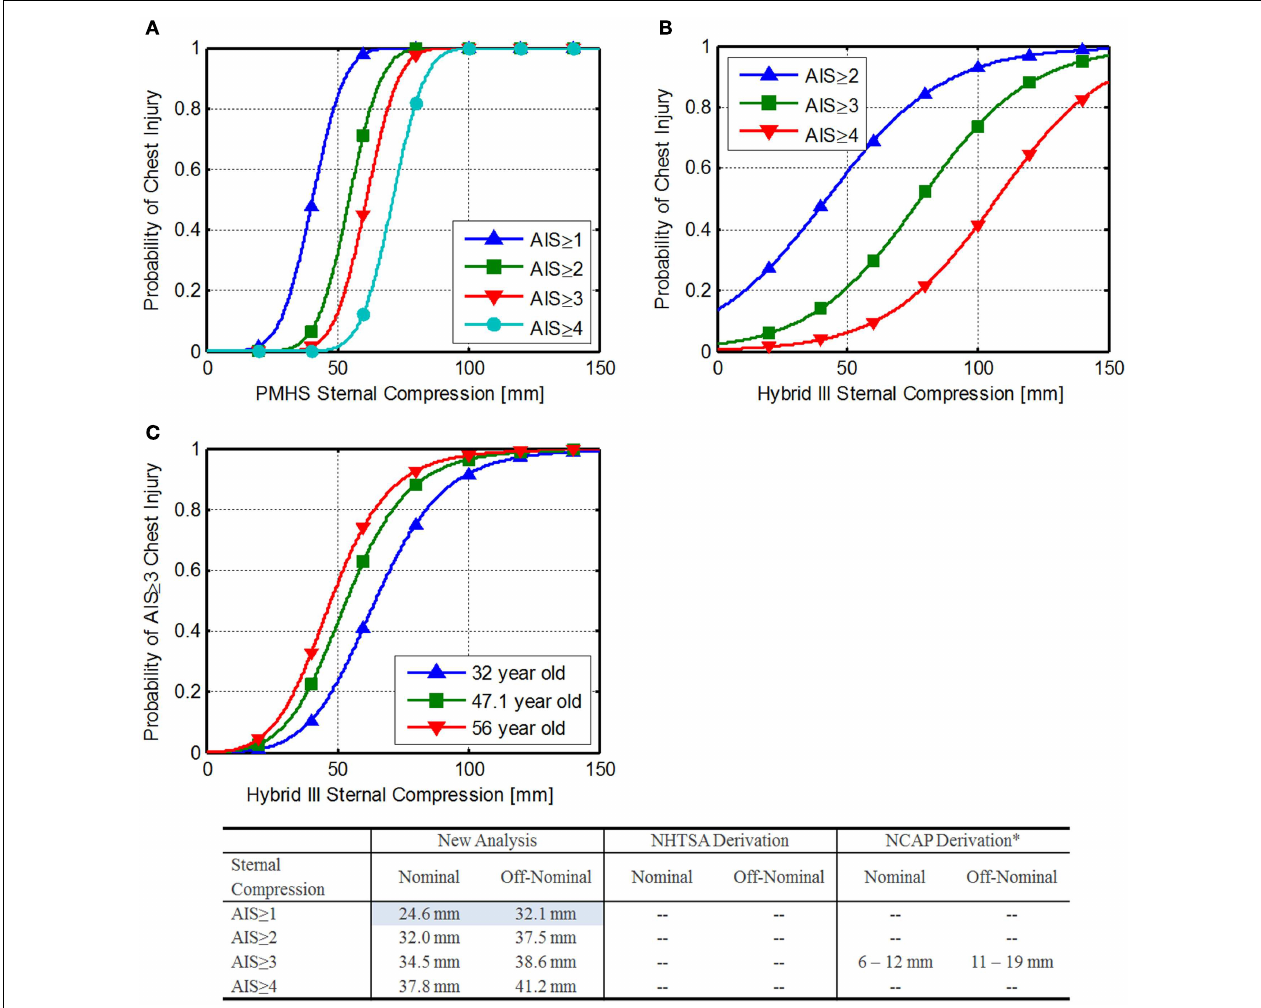
FIGURE 6 | Sternal compression injury risk . (A) Injury risk functions developed from Mertz et al. (1997), (B) NHTSA FVMSS 208 injury risk functions (National HighwayTraffic Safety Administration, 1998), and (C) NHTSA NCAP chest injury risk by age (National HighwayTraffic Safety Administration, 2008).